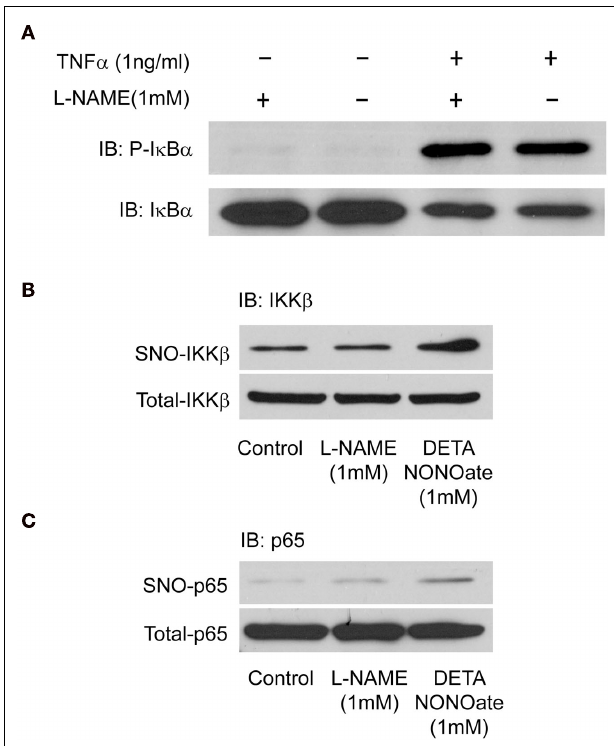
FIGURE 4 | Human aortic endothelial cells were pre-treated with L-NAME (1mM) for 30min and stimulated with (A) 1ngTNF α for 30min. Cells were lysed and the activation of NF- κ B was detected by immunoblotting using anti-phosphorylated I κ B α and total I κ B α antibodies. (B,C) HAECs were treated with L-NAME (1mM) or DETA NONOate (1mM) for 6h, and cells were lysed for biotin switch assay, biotin labeled samples were immunoblotted with anti-p65 and anti-IKK β